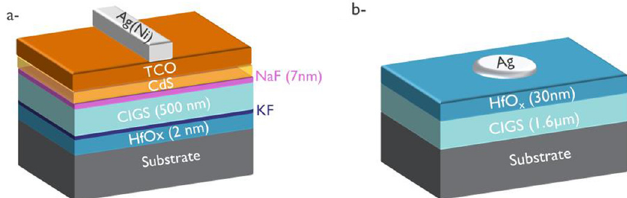
Fig. 1. Sample structure of (a) passivated solar cell and (b) MIS structure (Substrate: SLG/Si(O,N)/Mo) .